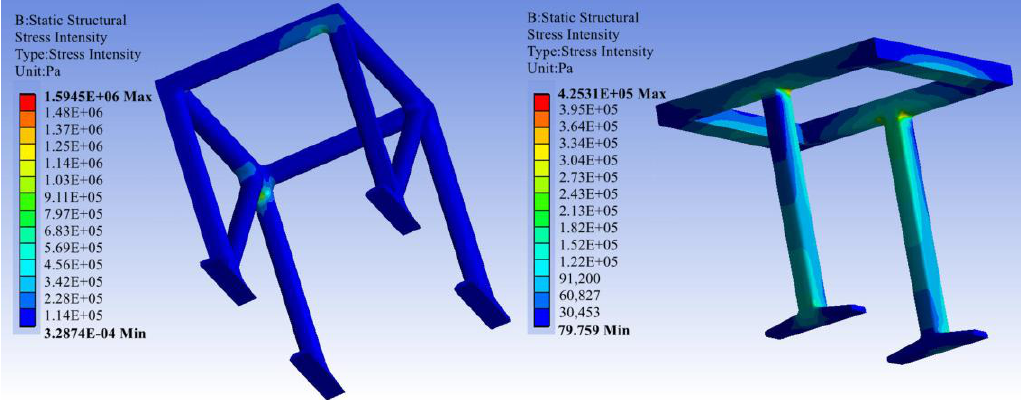
Figure 24. Stress analysis for comparison of the triangular hinge and simple straight hinge (stress intensity).